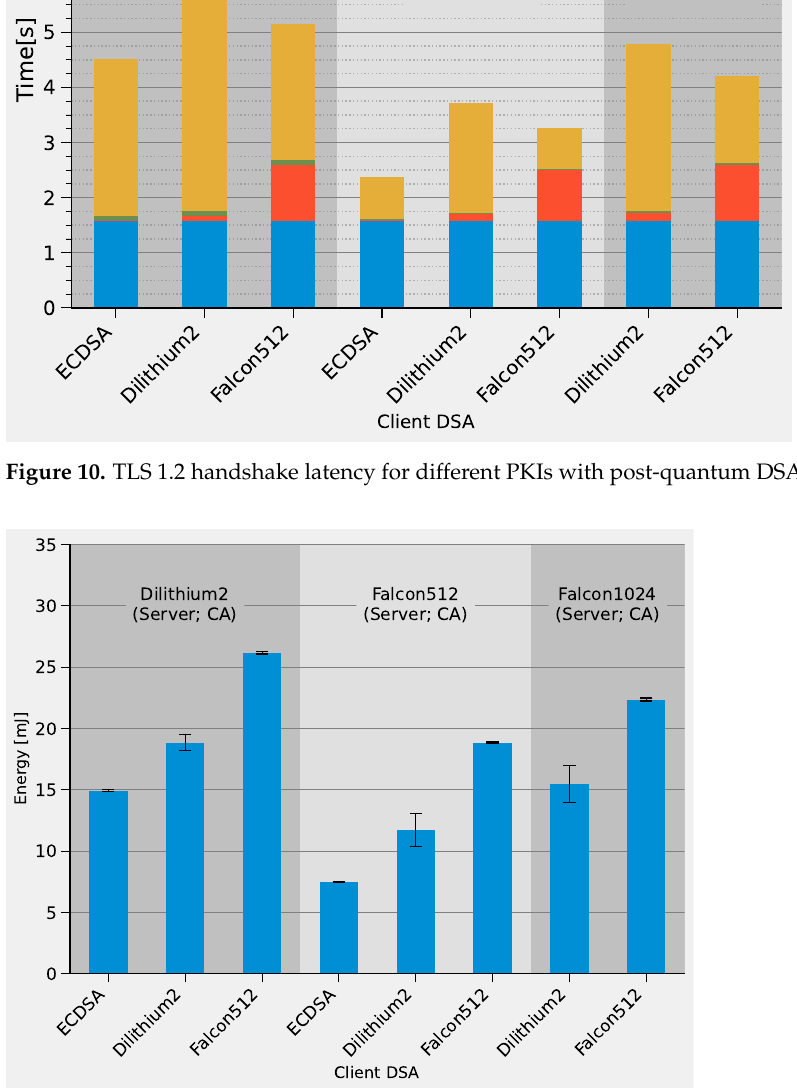
Figure 11. TLS 1.2 handshake energy demand for different PKIs with post-quantum DSAs. The chart shows that, in contrast to the KEMs, all post-quantum DSAs cause a signifi- cant increase in TLS handshake latency. PKIs that deploy Dilithium2-based server, client and CA certificates show the largest latency (second bar from the left), which is about four times that of the conventional ECDSA-based handshakes. Consistent with previous observations, this is mainly caused by the large communication overhead due to the high bandwidth requirements of Dilithium. This is different from the pure Falcon512-based PKI (sixth bar from the left), as it reduces latency by half compared to the Dilithium2 version. However, the signing function of Falcon512 is one of the main bottlenecks, as it has a major influence on latency and energy